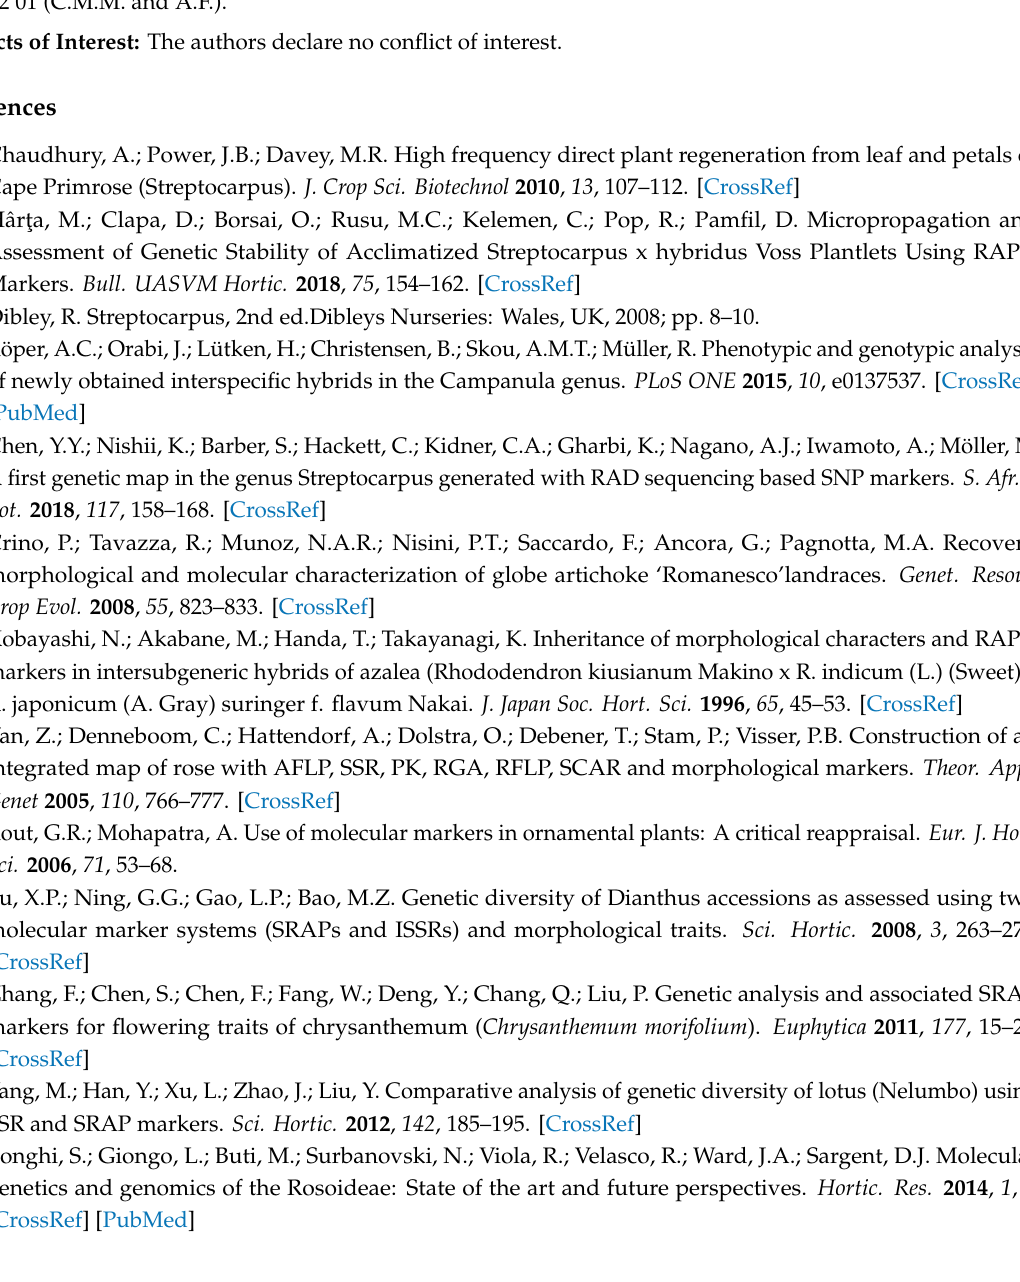
Table S1: Morphological characterization of genitors and F1 progenies selected for SRAP and FT-IR